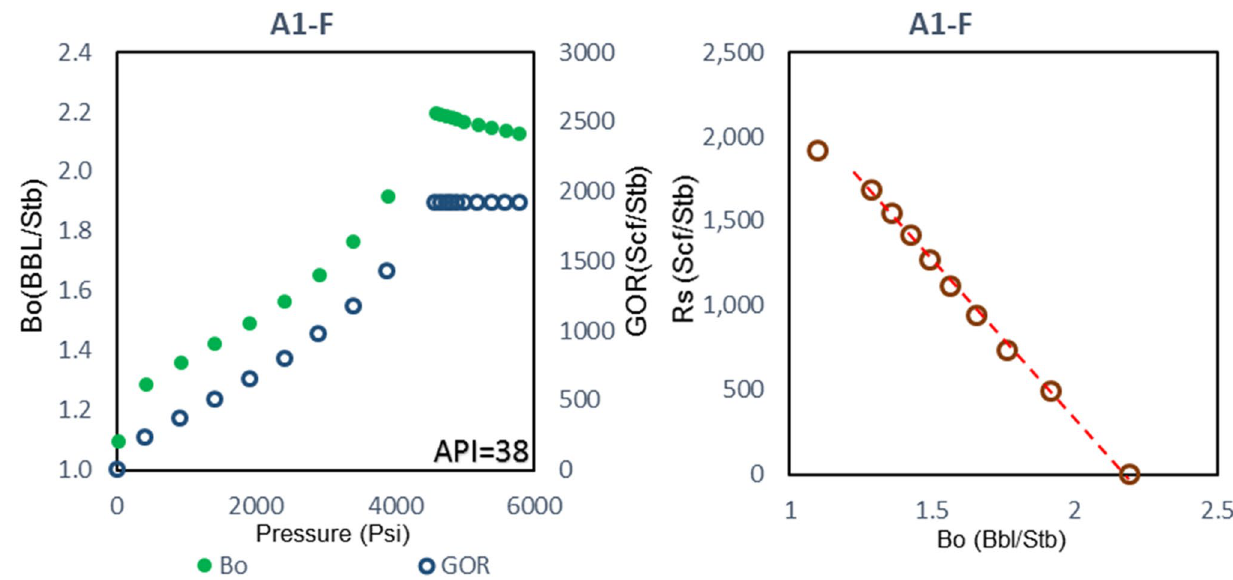
Fig. 7 GOR and Bo behavior of oil with API > 31-DL test—(A1-F)